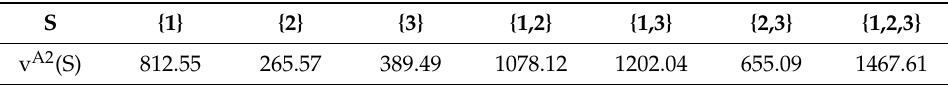
Table 17. Revenue of the coalitions under alternative